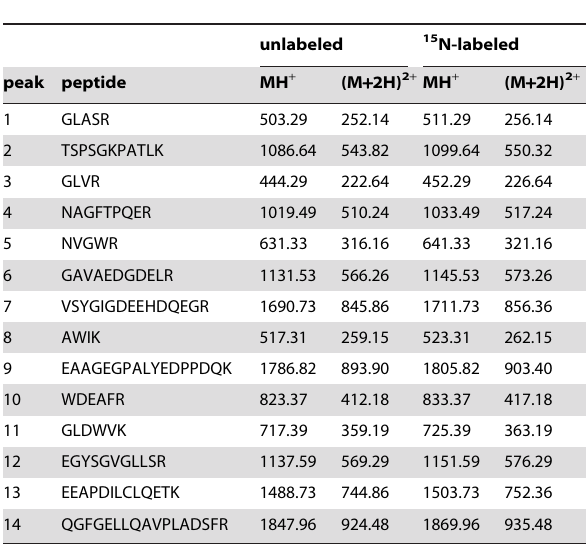
Table 1. Identification of the tryptic peptides in Figure 1 and the m/z values (Th) of the monoisotopic masses of their MH + and (M + 2H) 2 +